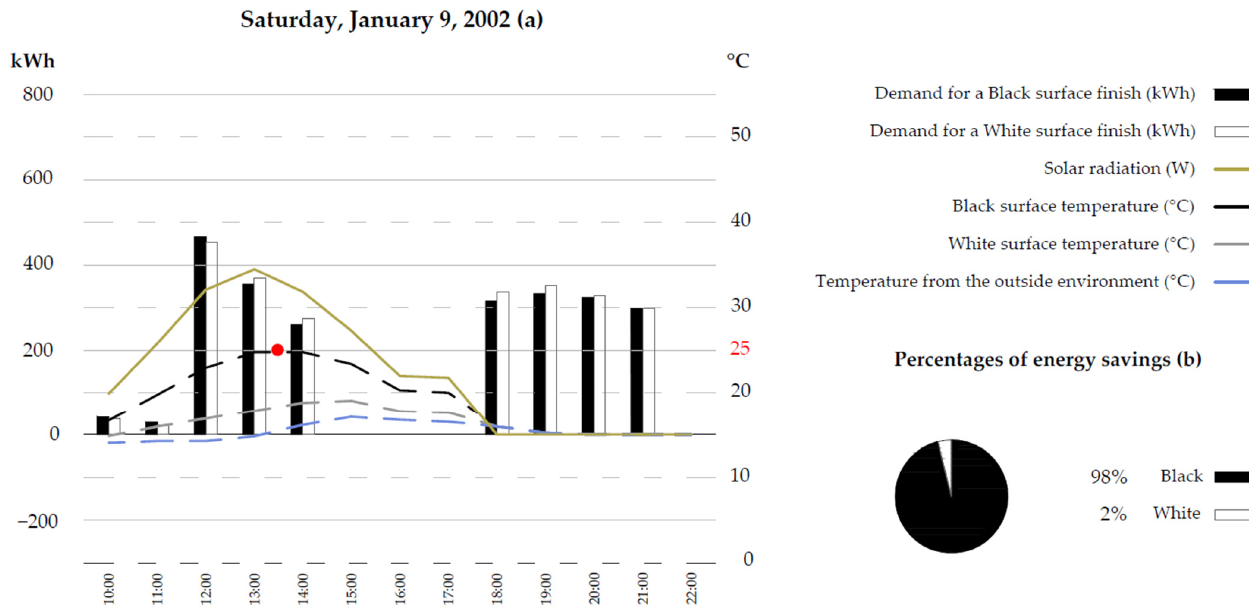
Figure 16. ( a ) Surface temperature and energy performance for 9 January 2002, in Barcelona. ( b ) White vs. black surface finish energy savings.